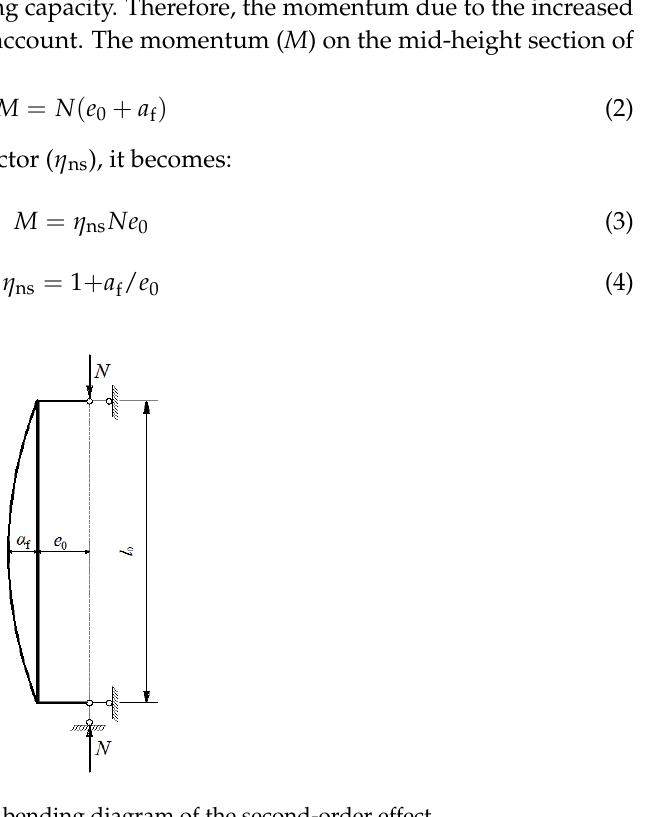
Figure 10. The longitudinal bending diagram of the second-order effect.